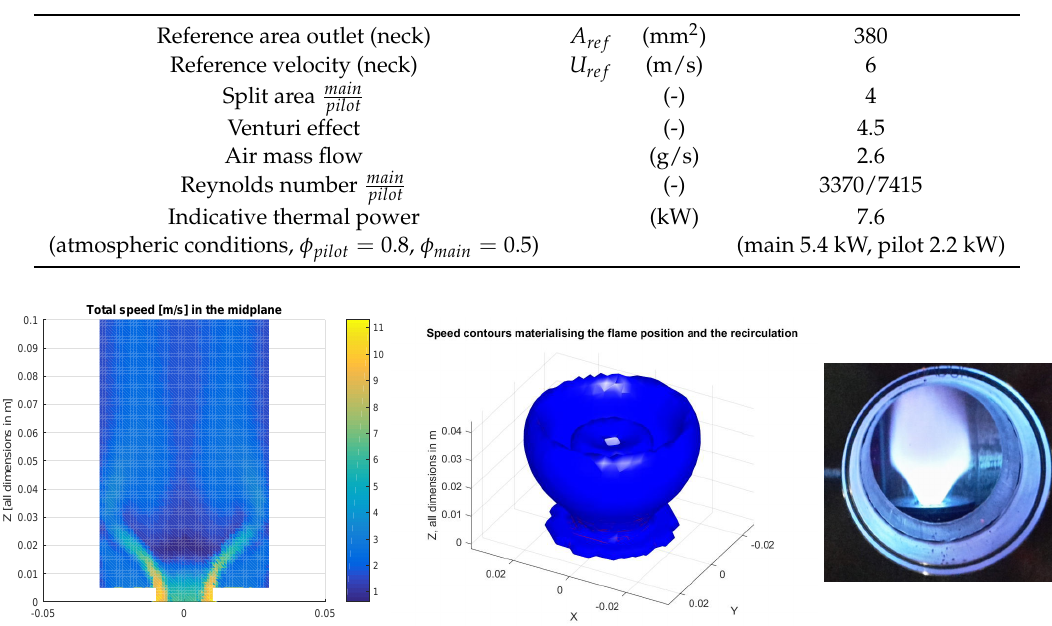
Figure 8. The CBO4 burner. Table 1. Design operation point at room conditions of the CBO4 burner.